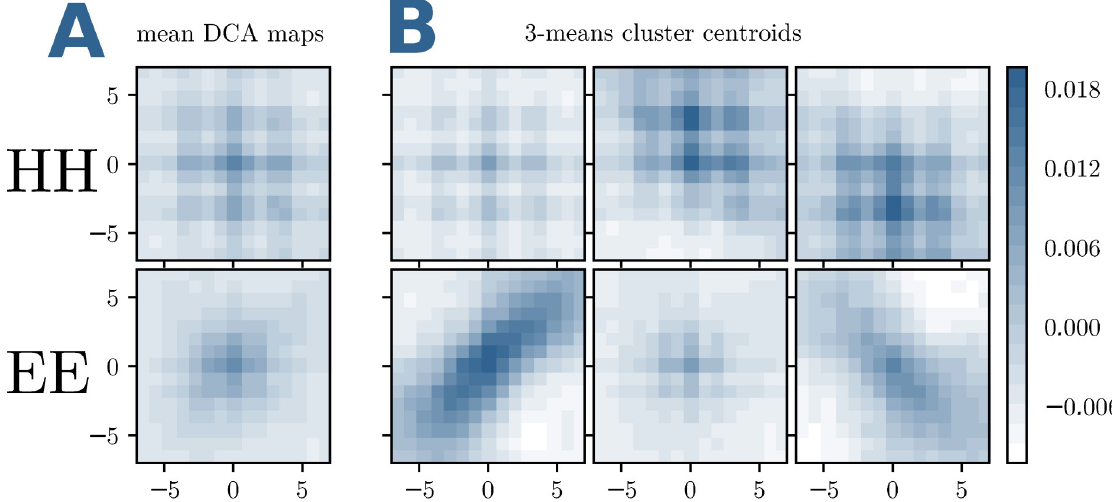
Fig 2. Typical patterns in DCA-score matrices. (A,B) The average DCA scores in a 15 × 15 window around an HH or EE contact are displayed, using the same selection of contacts as in Fig 1 for panels A, and the same sub-clustering for panels